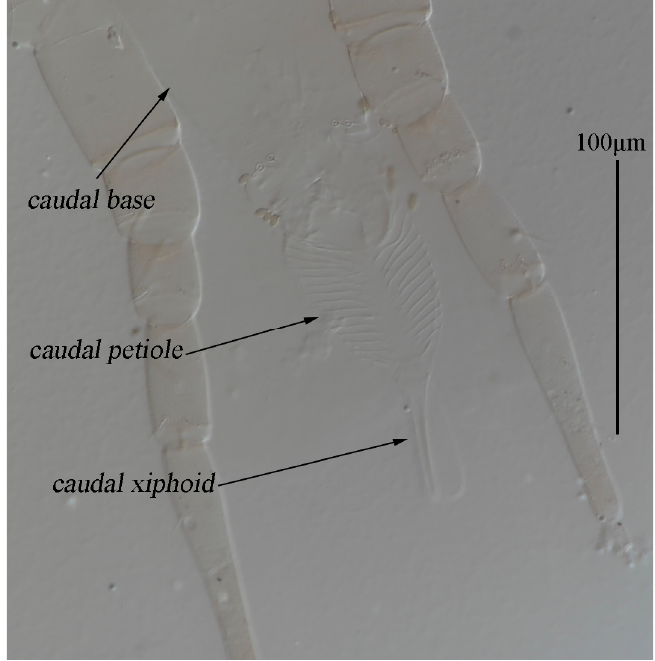
Figure 11. Cunaxicaudus neomohanensis sp. nov . (male). Cauda (photo). Scale bar = 100 µm.